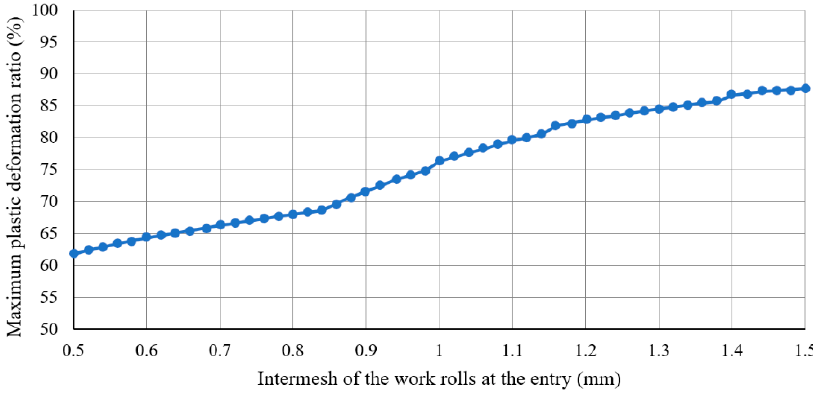
Figure 7. Influence of the intermesh of the work rolls at the entry on the maximum plastic deformation ratio.